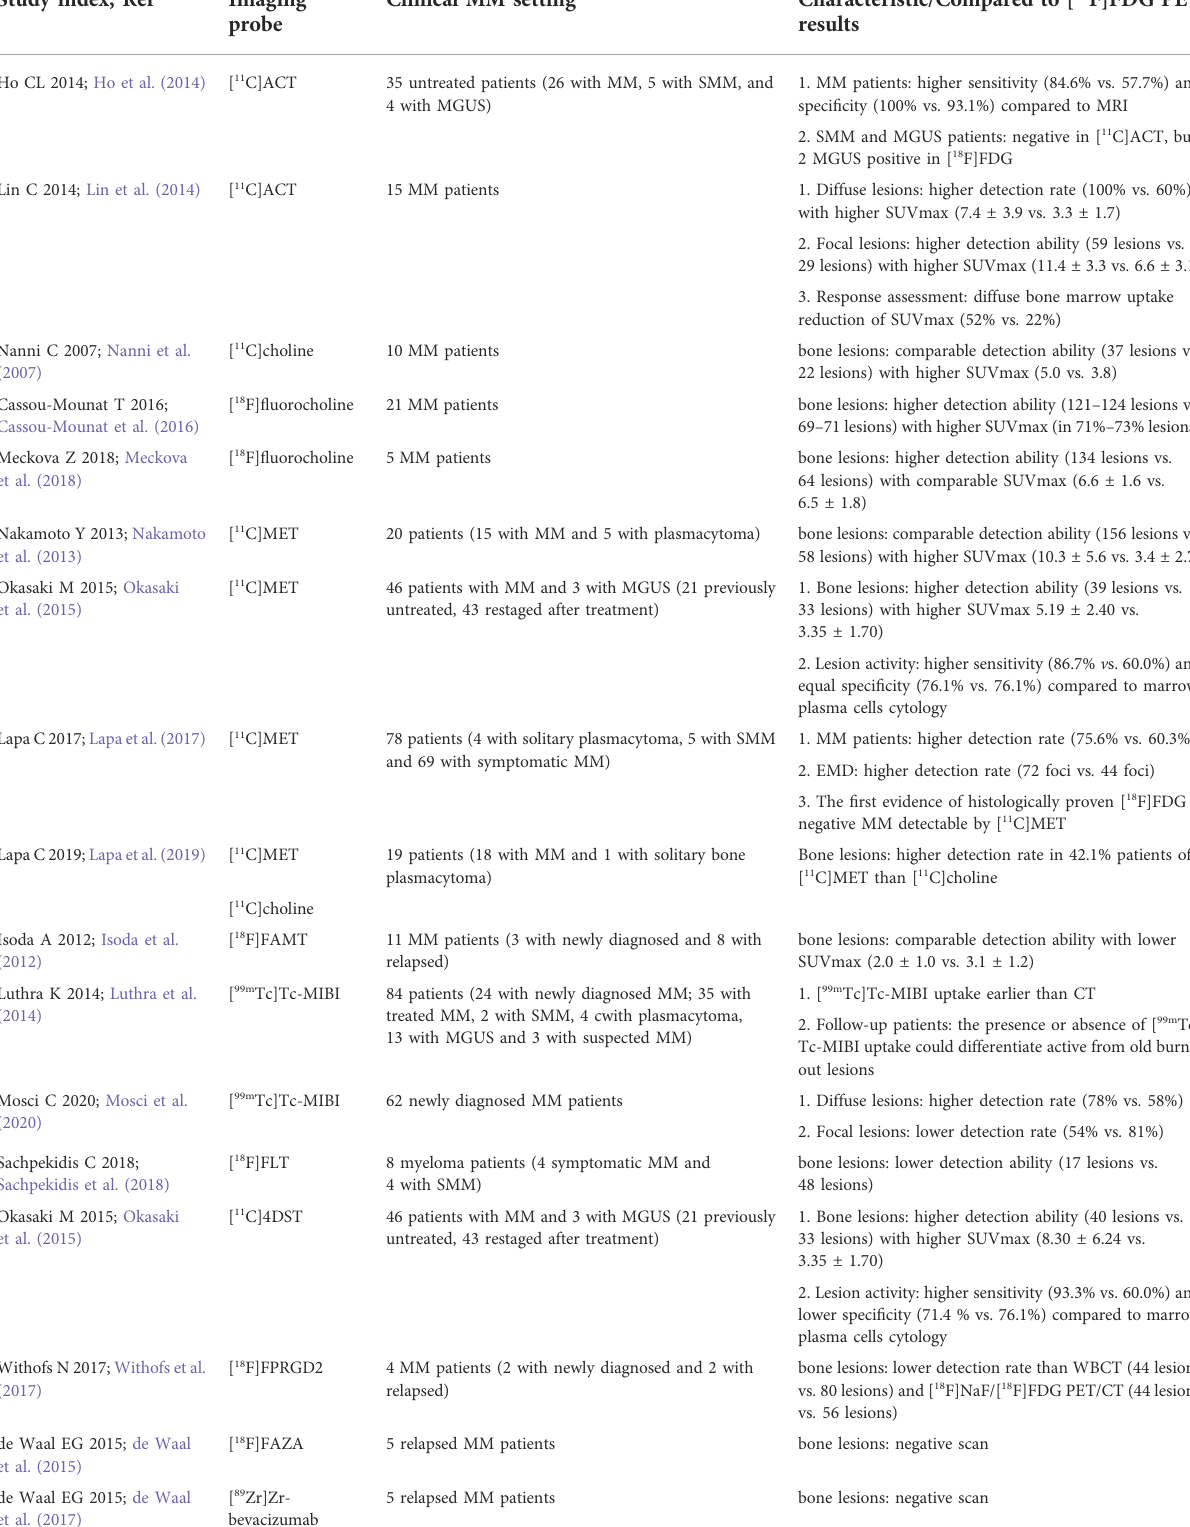
TABLE 2 Reported MM related imaging probe at clinical evaluation level.